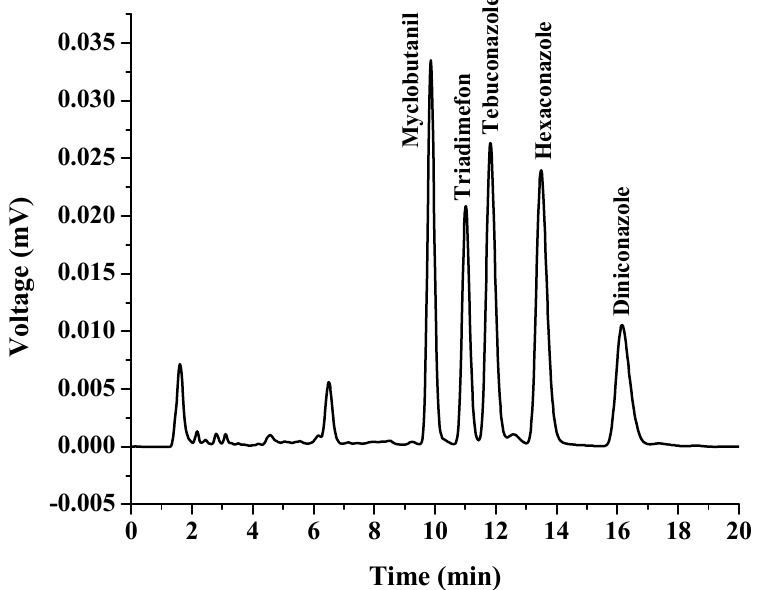
Figure 9. Chromatogram of standard triazole fungicides obtained with preconcentration using the proposed in situ coacervative extraction based on a double-solvent supramolecular system. The concentration of all standards was 100 µ g L − 1 . Conditions: Sample 10 mL, double SUPRA (50 µ L of 1-dodecanol and 50 µ L of 1-undecanol), vortex time 30 s, and centrifugation 2500 rpm for 5 min. Finally, collection of the top layer for HPLC analysis.